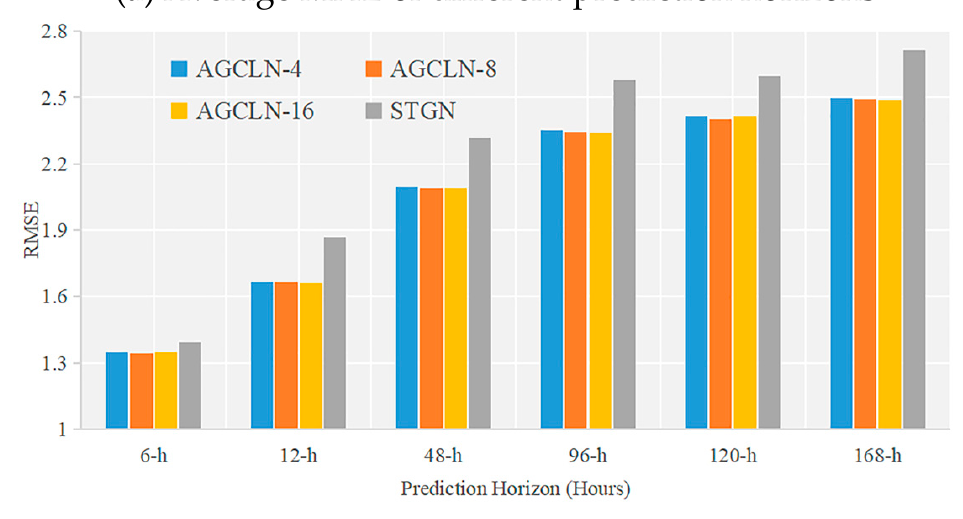
Table 6. RMSE of forecasting methods of di ff erent K and dilation factor d for 40 nodes. Prediction Scale